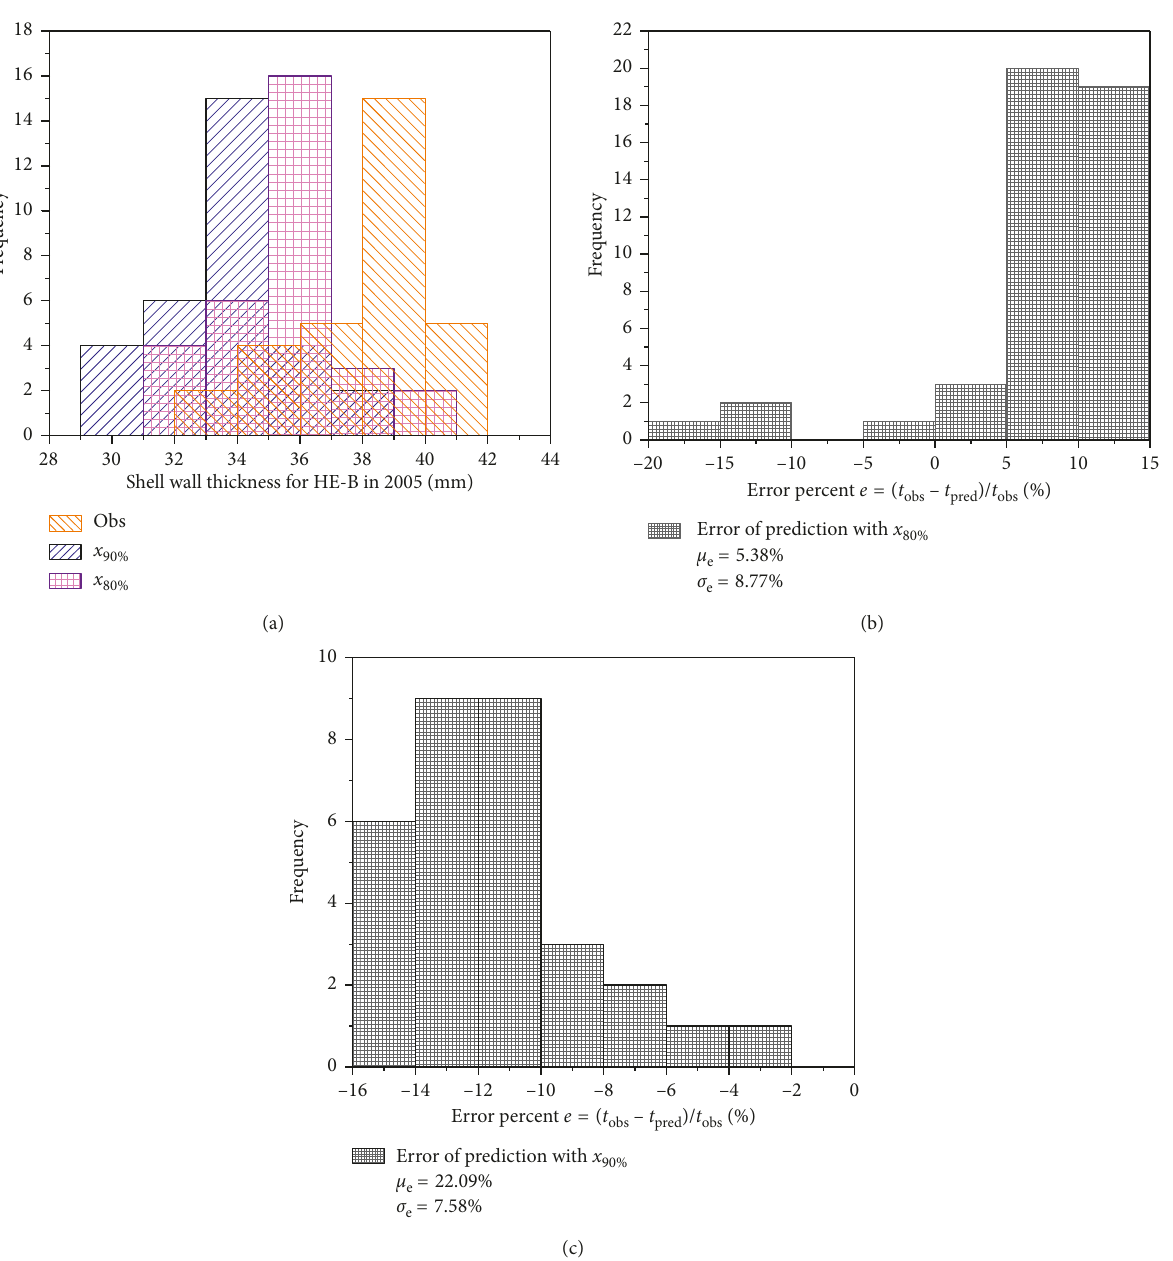
Figure 8: Histogram of the predicted wall thickness and the observed in HE-B (a) with the prediction error histogram using x 80% (cid:31)